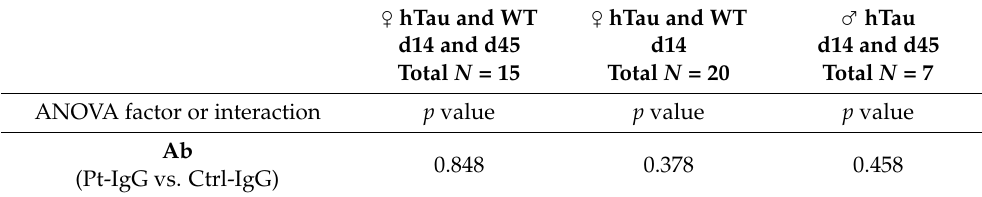
Table A6. Statistical analysis of neck EMG during